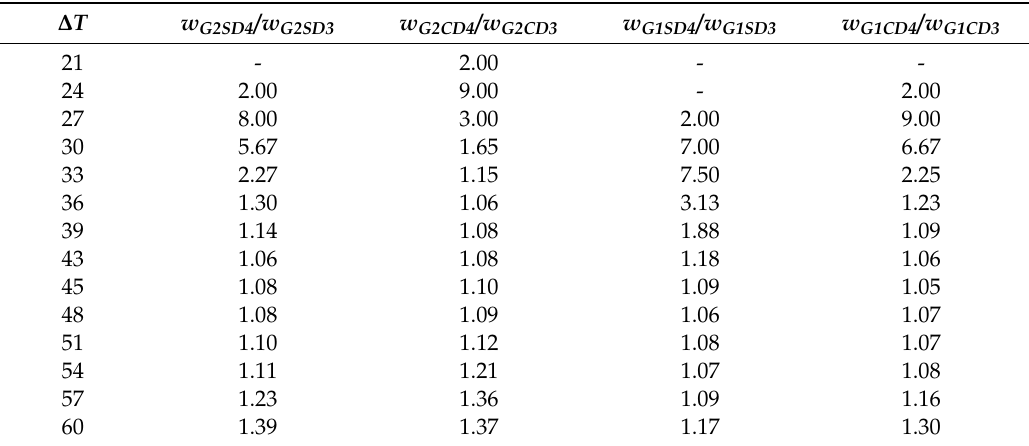
Table 4. Relative di ff erences in the evolution of the crack opening in D3 and D4